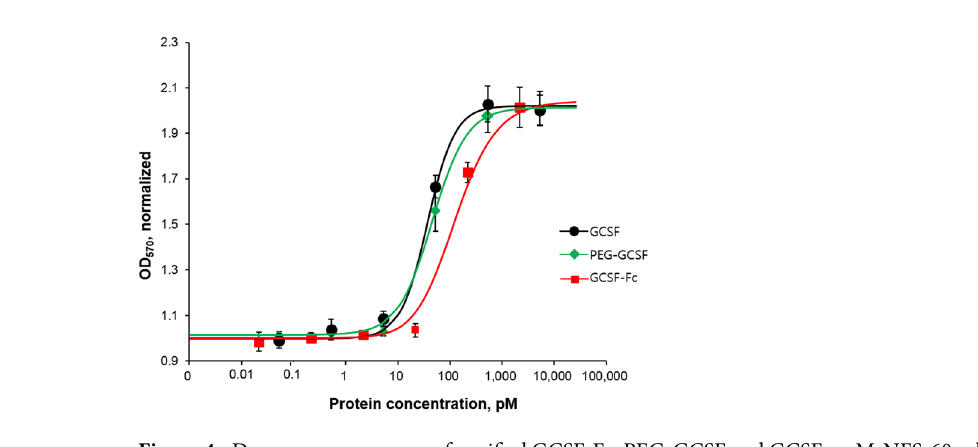
Figure 4. Dose-response curves of purified GCSF-Fc, PEG-GCSF and GCSF on M-NFS-60 cell line. The number of cells was measured at OD 570 following a standard MTT assay protocol. Data are represented as the mean ± SE of n ≥ 3 of 2 independent